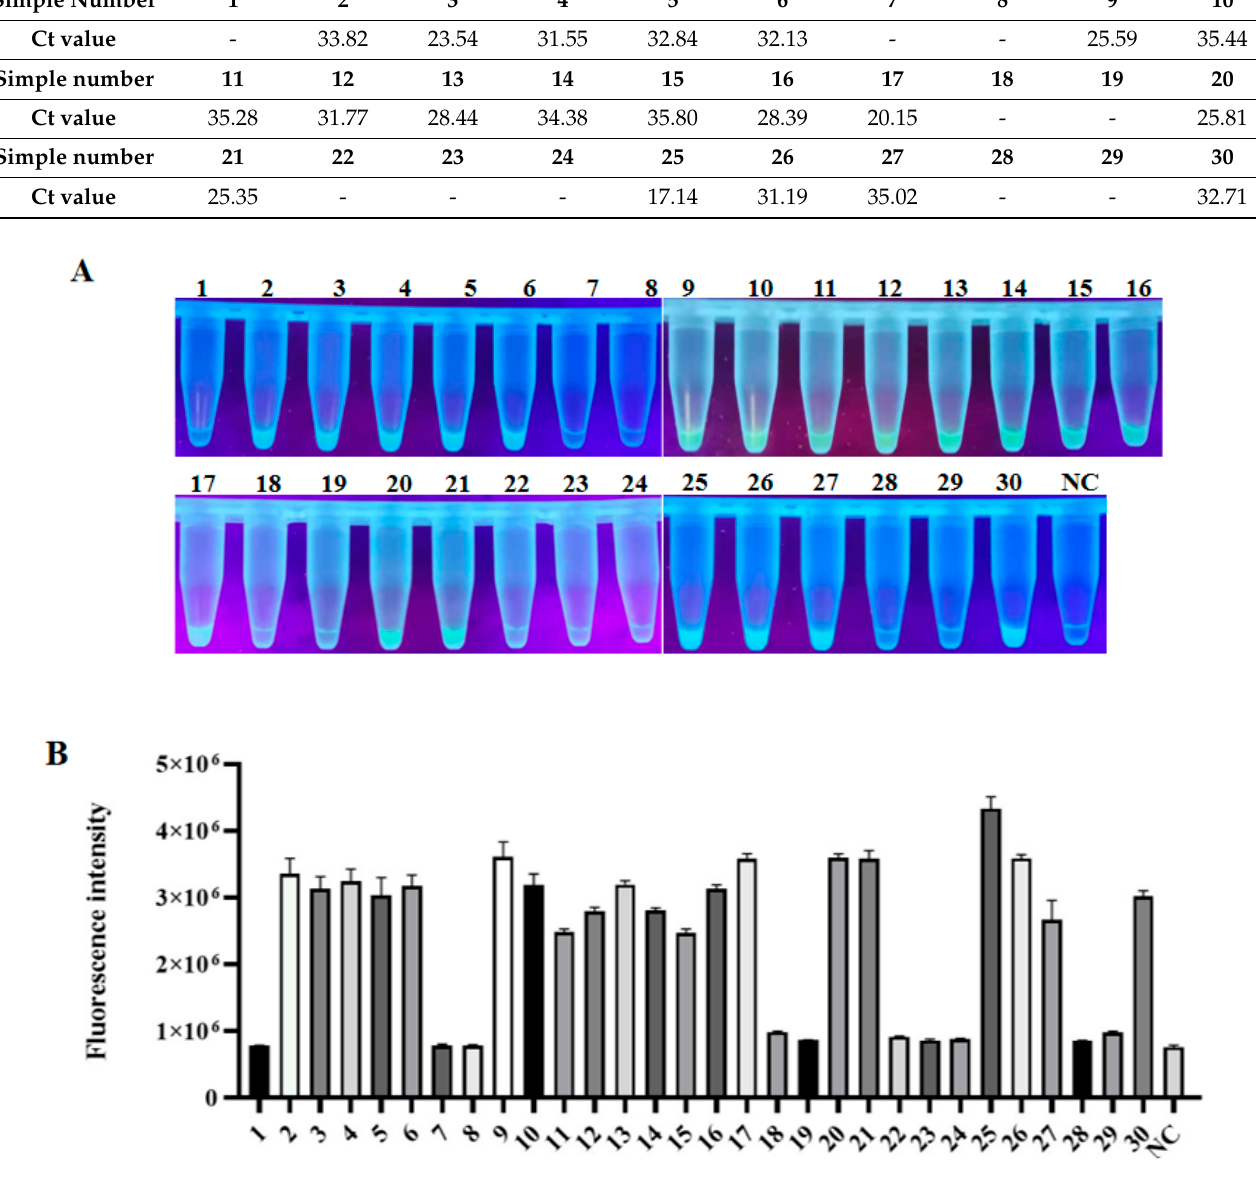
Figure 5. Detection of PCV2 in swine clinical samples by LAMP-CRISPR approach. ( A ) 30 clinical blood samples were tested by the LAMP-CRISPR assay. ( B ) Fluorescence intensity corresponding to each indicated tube. ( n = 3 technical replicates, value represents mean ± SEM).